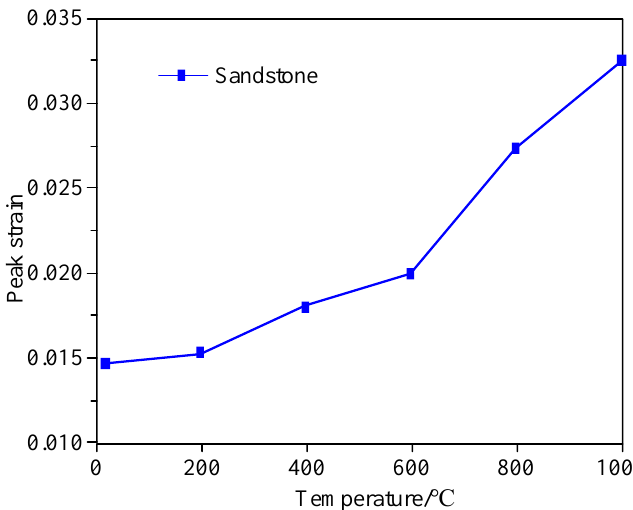
Figure 6. Variation curve of sandstone peak strain with temperature.